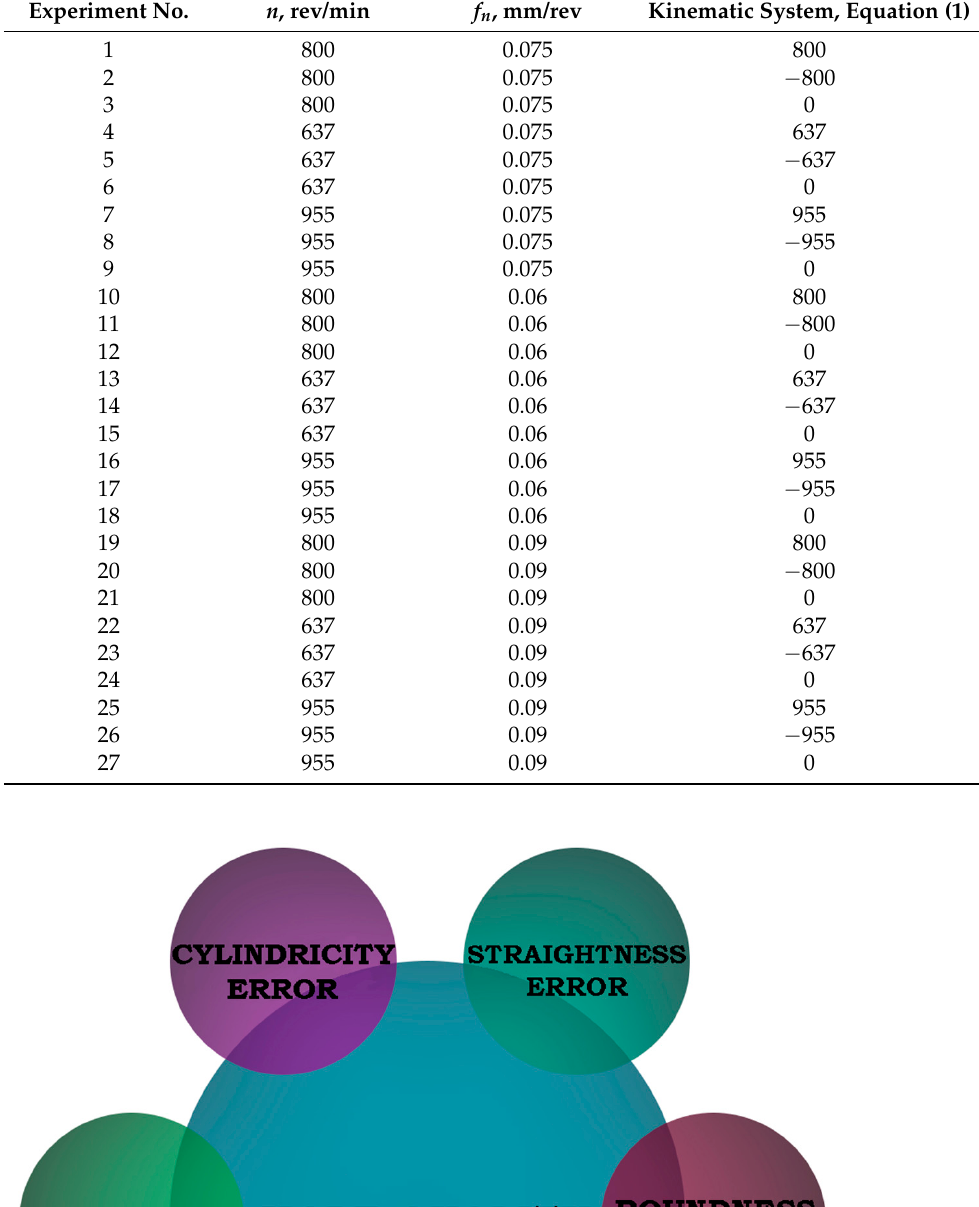
Table 5. Input parameters used in the drilling experiments.